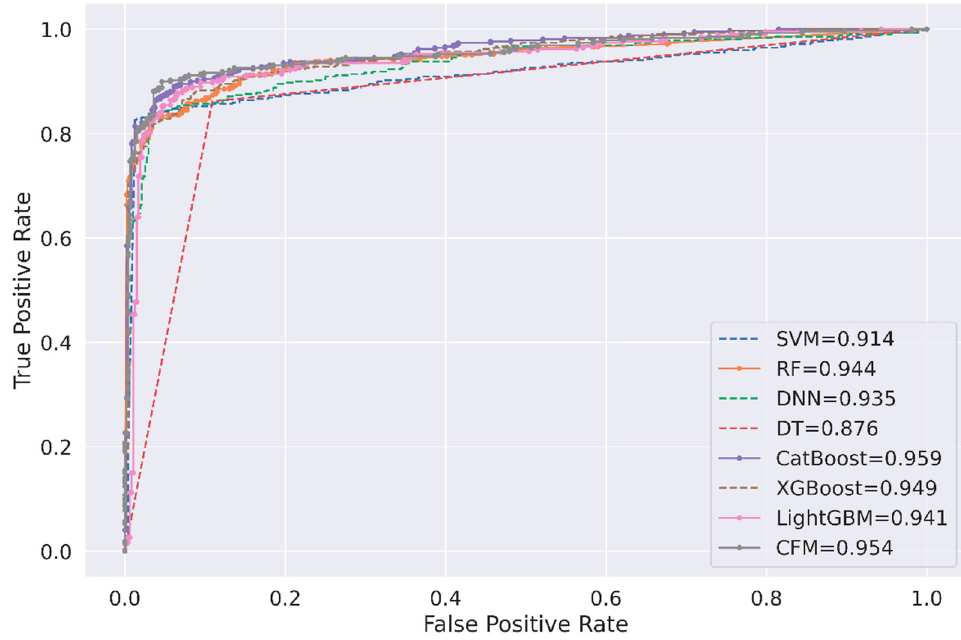
Figure 13. A comparison of the ROC curves and AUC values of the 8 models using the test dataset for Gorganrud basin. Support Vector Machine (SVM), Random Forest (RF), Deep Neural Network (DNN), Decision Tree (DT), Light Gradient Boosting Machine (LightGBM), Categorical Boosting (CatBoost), Extreme Gradient Boosting (XGBoost), and Cascade Forest Model (CFM).